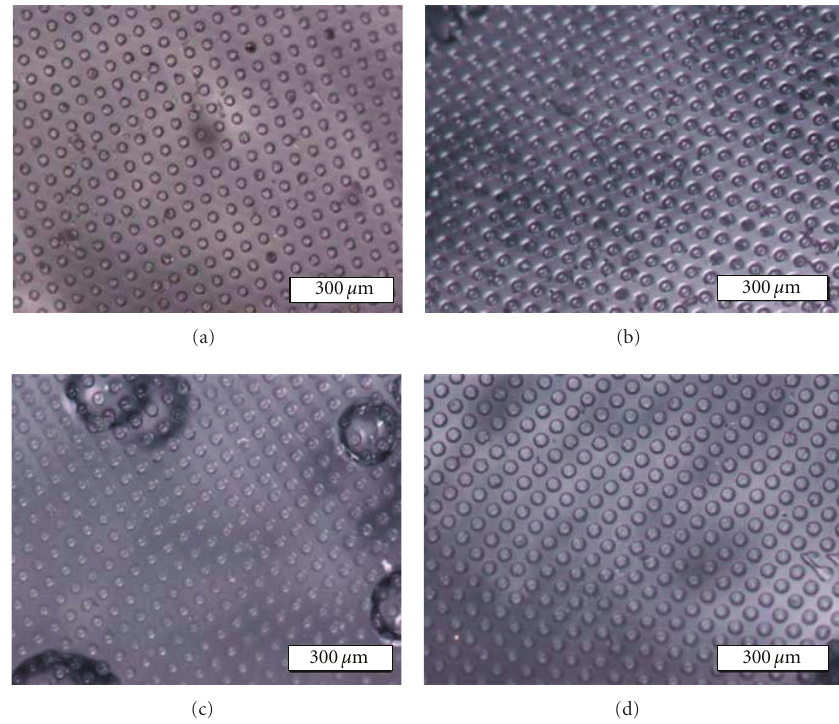
Figure 19: The PDMS optical film of D40-B microlens array (a) the first scale (34 µ m), (b) the second scale (23 µ m), (c) the third scale (13 µ m), and (d) the forth scale (6 µ m).